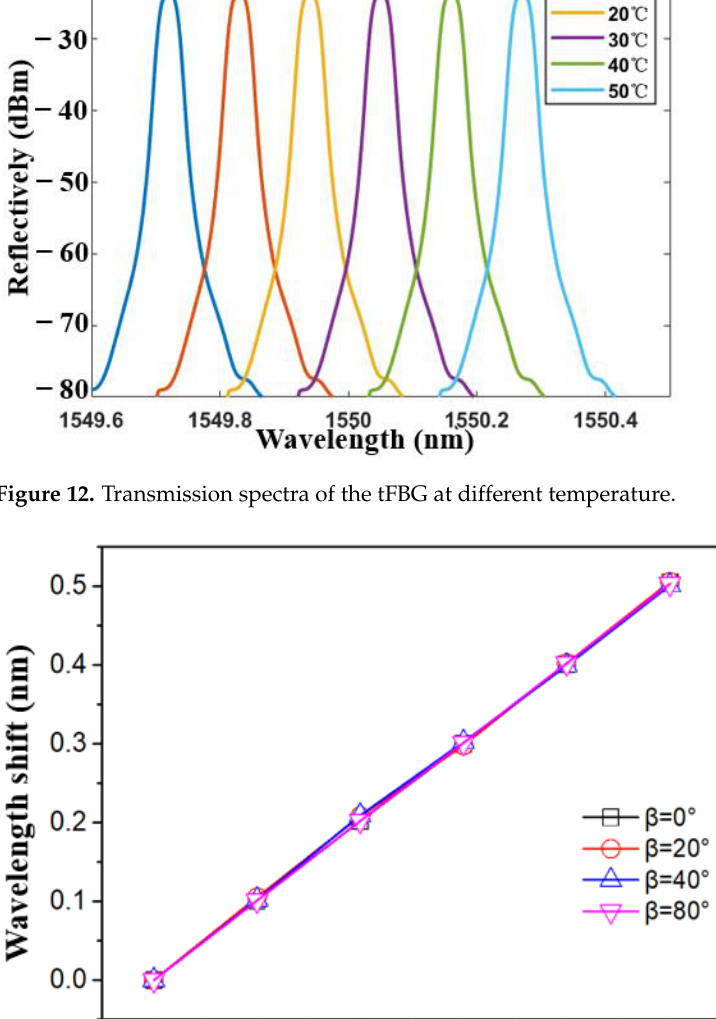
Figure 14. The dependence of the reflection spectrum at the wavelength of the reflection peak at different inclination angles in FRL with waist equals 75 µm.